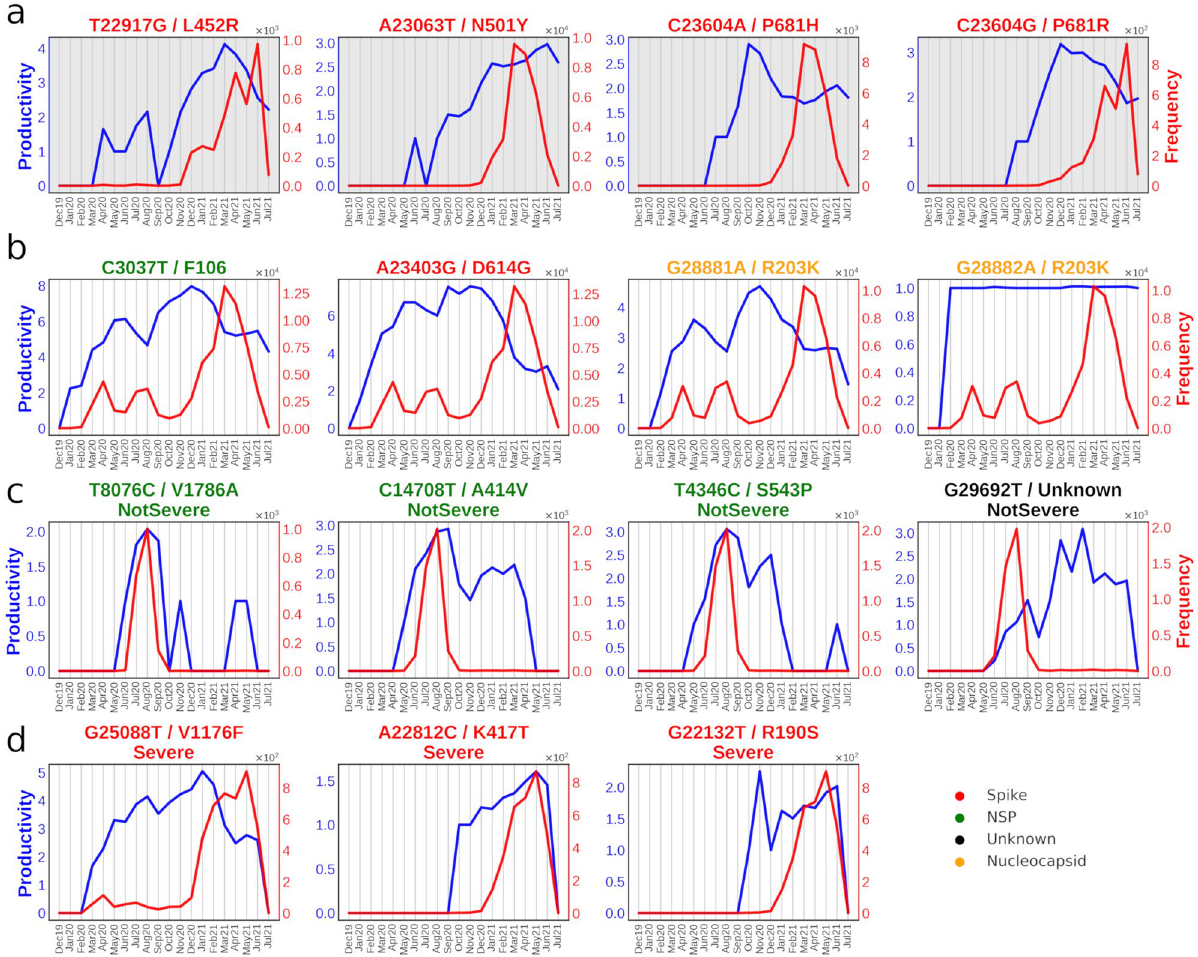
Figure 6. Temporal Frequency and Productivity of selected 15 mutations. Red and blue lines indicate frequency and productivity (tendency to form multi-word associations) of mutations. ( a) comprises four mutations of concern (MoC). ( b) comprises of four most frequent mutations in the corpus. ( c) and ( d) panels comprise of mutations of the ’NotSevere’ and ’Severe’ categories, respectively. Note that nucleotide mutations coloured in black (as Unknown) are on